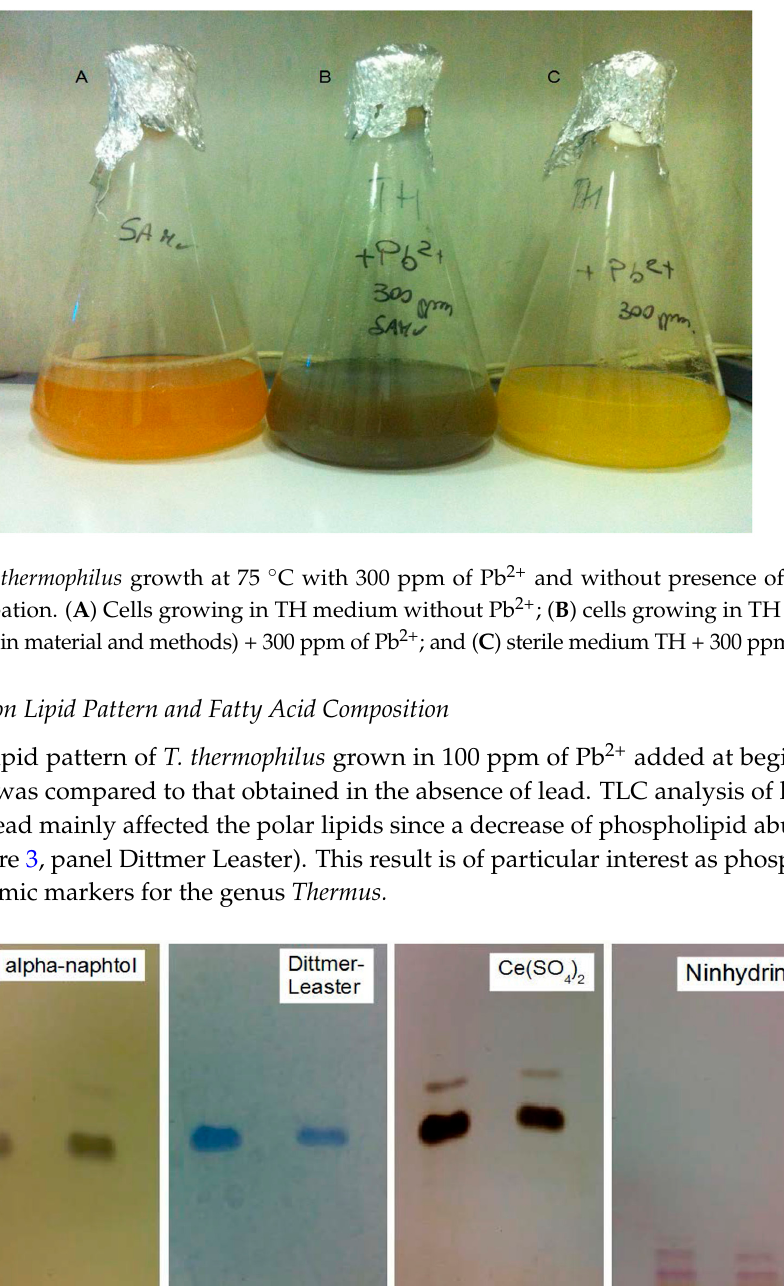
Figure 3. Thin layer chromatography (TLC) of polar lipids, extracted from freeze drying cells of